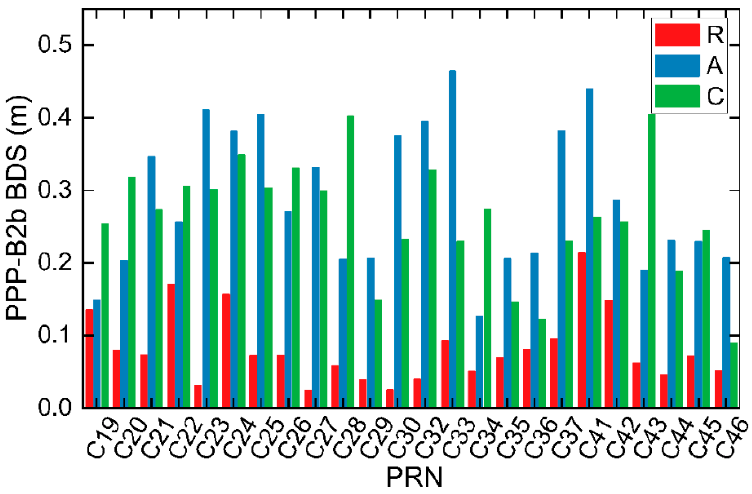
Figure 3. RMSEs of the PPP-B2b orbits for BDS-3 satellites.